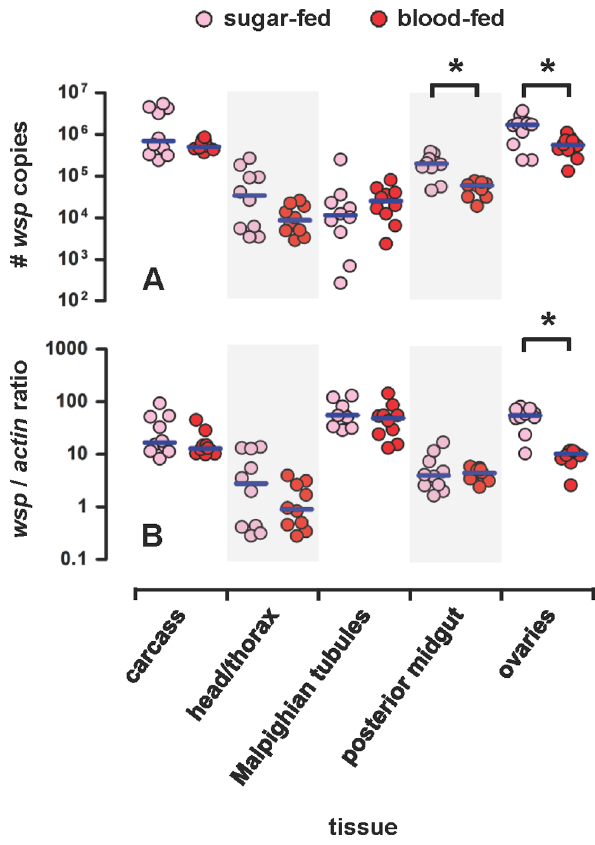
Figure 8. Tissue-specific density of w Flu in sugar- and blood- fed adult female Ae.fluviatilis . Graphs showing the absolute (A) and relative (B) densities of w Flu in different tissues of adult females of the wildtype strain ( wolb + ) of the mosquito Ae. fluviatilis . The density of w Flu was estimated using real-time quantitative PCR of the Wolbachia - specific wsp gene and the mosquito-specific actin gene (see Materials and Methods for details). Each circle represents a single pool of 5 individual organs taken from different age- and cohort-matched individuals, while the blue horizontal bars indicate either the median number of wsp copies (Graph A) or the median wsp / actin ratio (Graph B) per individual. The data shown are from two independent biological replicates (i.e., two different generations of the laboratory colony of Ae. fluviatilis ). Three to 5 day-old adult females were separated into two groups after eclosion from pupae, and one group was blood-fed, while the other was maintained on sugar only. Twenty-four hours later (i.e., after blood-feeding, when the females were 4 to 6 days old), both sugar-fed and blood-fed individuals were dissected, and their organs harvested. In graph A, the absolute density of w Flu per individual organ was estimated by dividing the calculated number of wsp copies for each sample (i.e., pool of organs) by the number of organs in each pool (i.e., 5 organs). The cohorts (i.e., generations) of mosquitoes assayed were different from those used in Figure 7, such that the data presented in the two figures are not directly comparable, although they give consistent results. Comparisons marked with an asterisk (*) were significantly different between sugar- and blood-fed females using a Mann-Whitney U test, while unmarked comparisons were not significantly different between sugar- and blood-fed females. Statisti- cally significant differences were also observed between some of the different tissues as described in the main text.